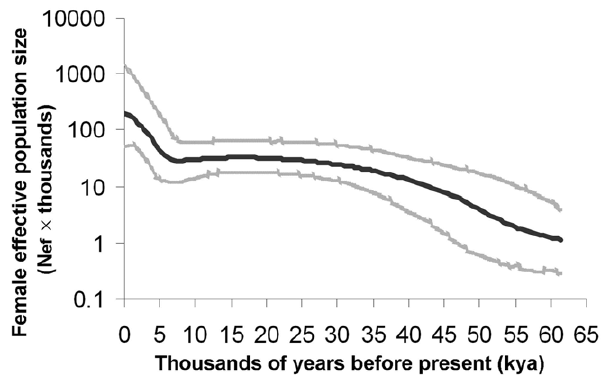
Figure 1. BSP of female effective population size (N ef ) through time for total Japanese mtDNA lineages. The bold black line represents the median population size estimate from Bayesian posterior distribution. The grey lines delimit the 95% highest posterior density (HPD) boundaries, accounting for uncertainty in the reconstructed phylogeny and substitution model parameters. N ef is plotted on a log scale and assumes a generation time of 20 years [66]. All the lines were drawn within the lower 95% HPD boundary of the maximum time to the coalescent age.